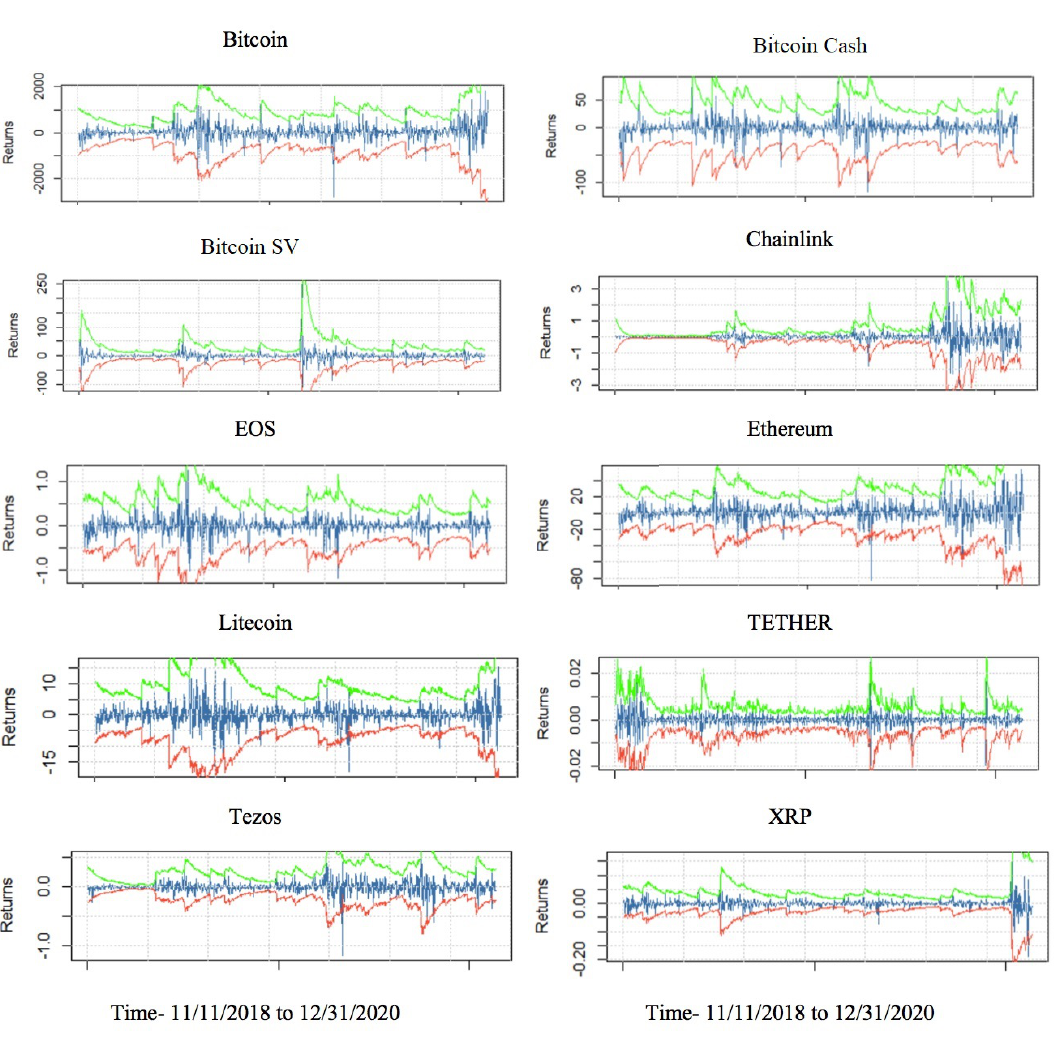
Figure 8. Value at risk backtesting for daily portfolio of top ten